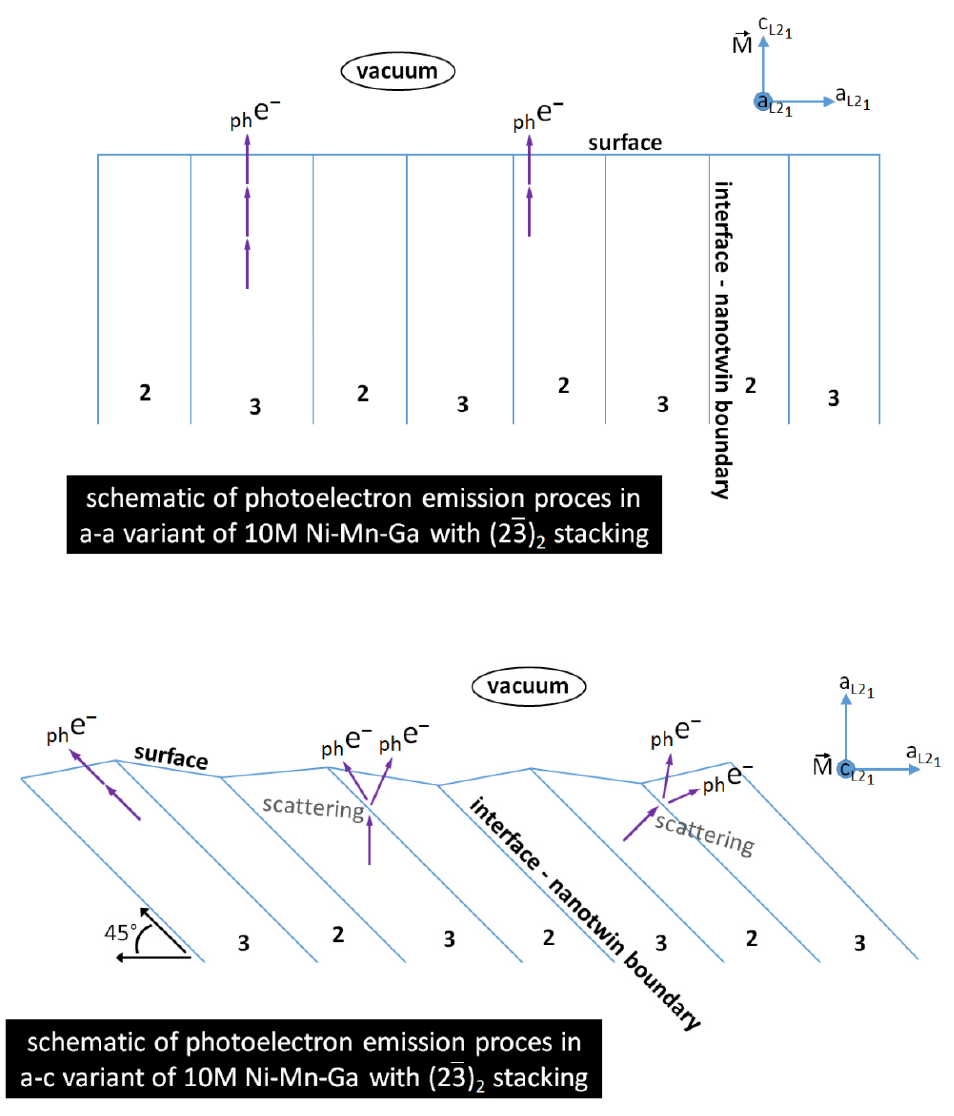
Figure 5. Scheme of photoelectrons’ trajectory during photoemission in martensite; comparison of a-a and a-c variants.